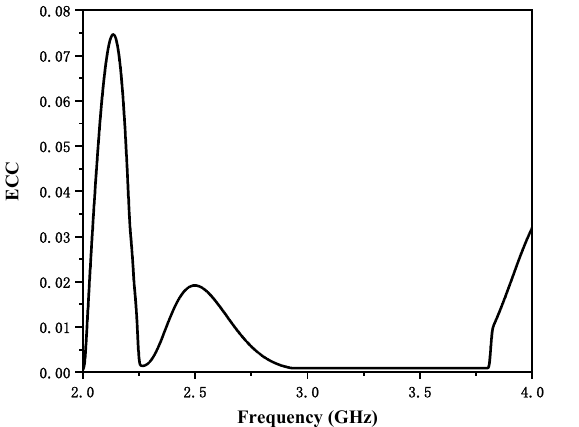
Figure 9. Simulated envelope correlation coefficient (ECC) of the multiple-input and multiple-output (MIMO) antenna. Table 2. Comparison of the proposed antenna with other referenced antennas. Center Ref.